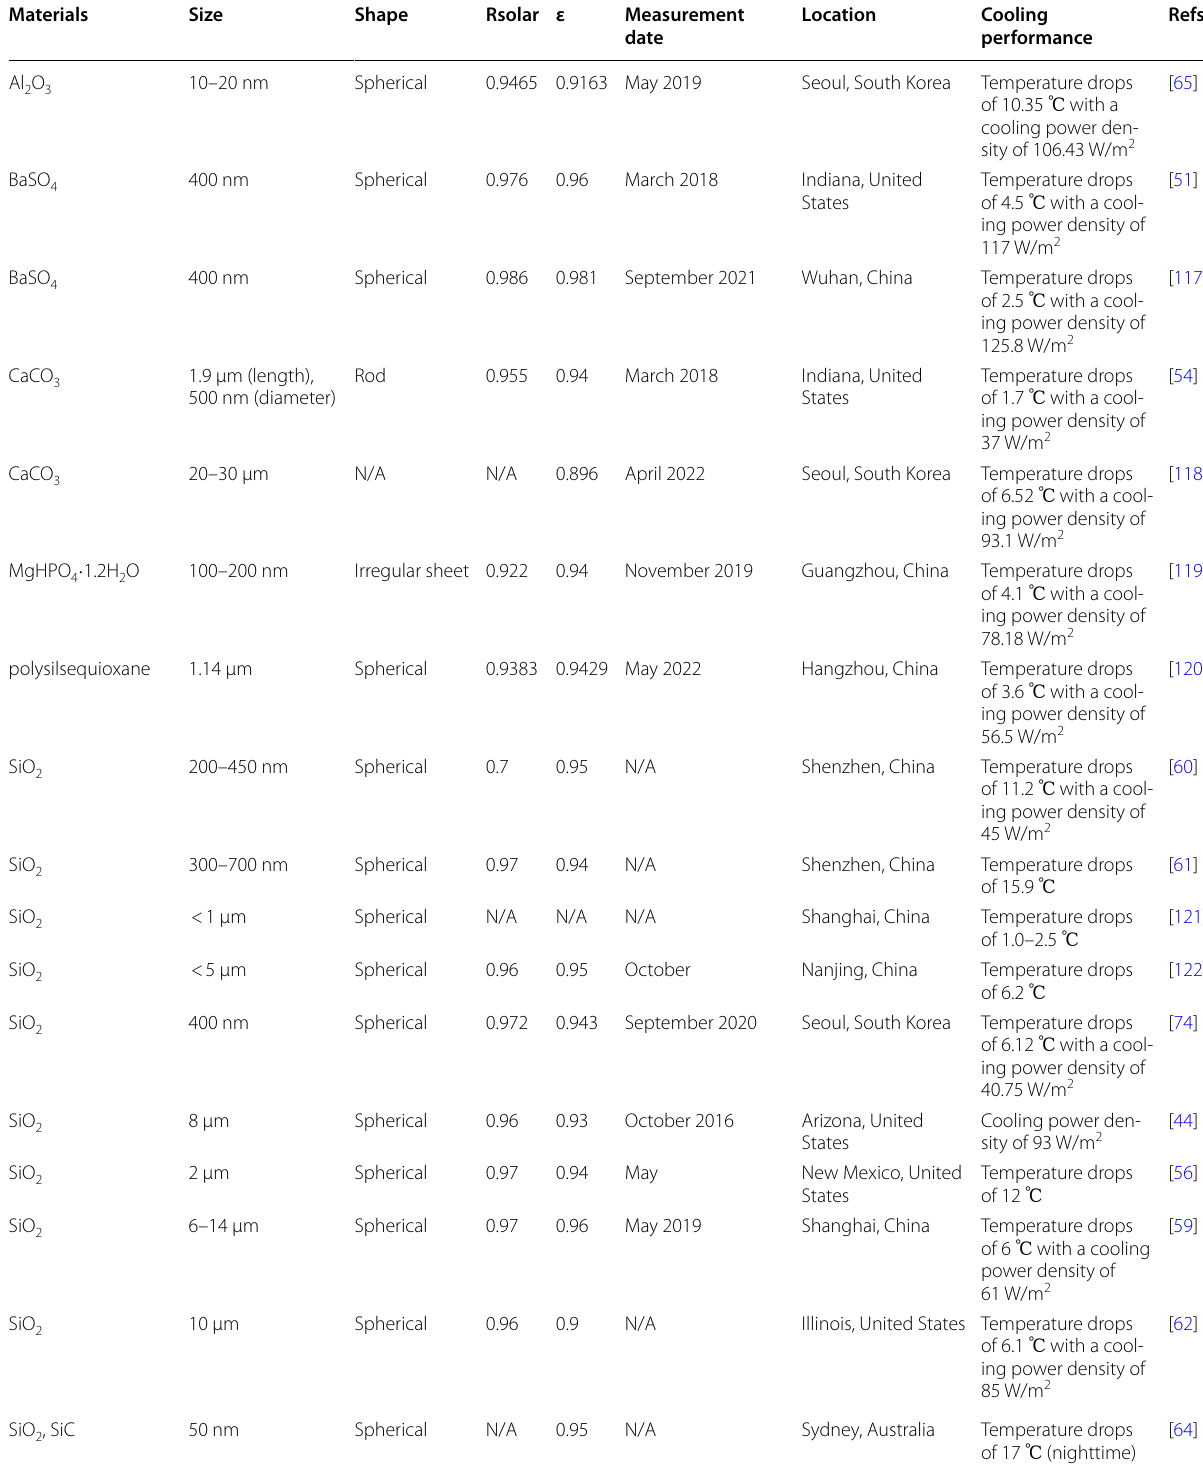
Table 1 Summary of materials, and properties of RC materials